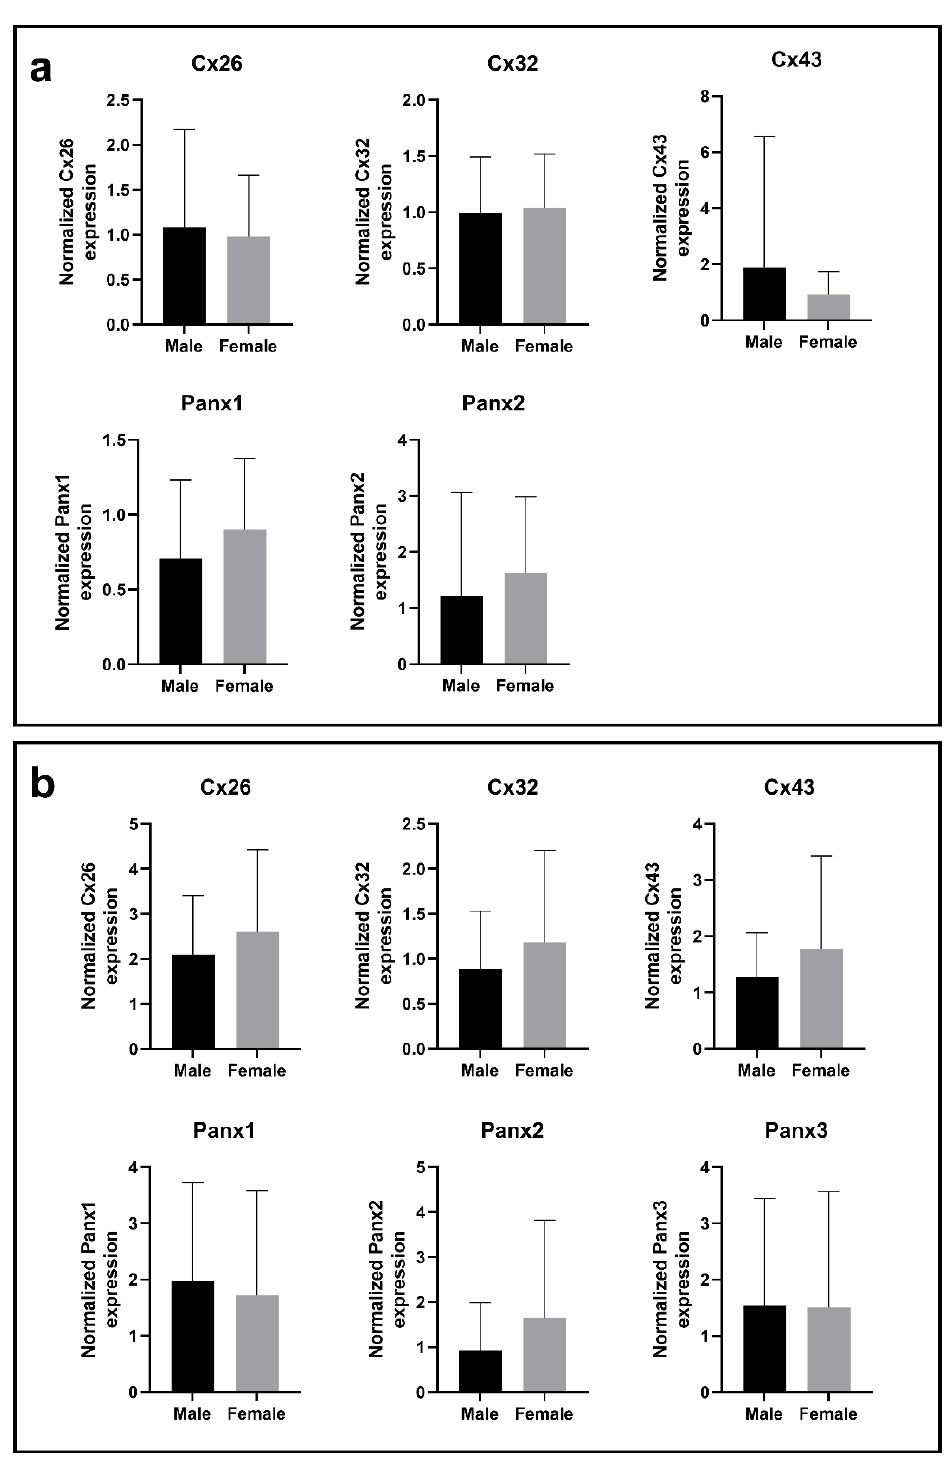
Figure 3: Cx and Panx gene (a) and protein (b) expression in male samples and female samples. RT-qPCR analysis ( a ) and immunoblot analysis ( b ) of Cx26, Cx32, Cx43, Panx1, Panx2 and Panx3 was performed. Relative gene expression compared to a pooled sample was calculated with the Pfaffl method (Pfaffl, 2001). Protein levels were normalized to the total protein loading and expressed as a ratio to a pooled sample. Male samples (RT-qPCR: N = 51, n = 2; immunoblot: N = 53; n = 1) and female samples (RT-qPCR: N = 16; n = 2; immunoblot: N = 16; n = 1) were compared with a Mann-Whitney test or unpaired t-test depending on the normality of the data distribution. Graphs display data as mean +